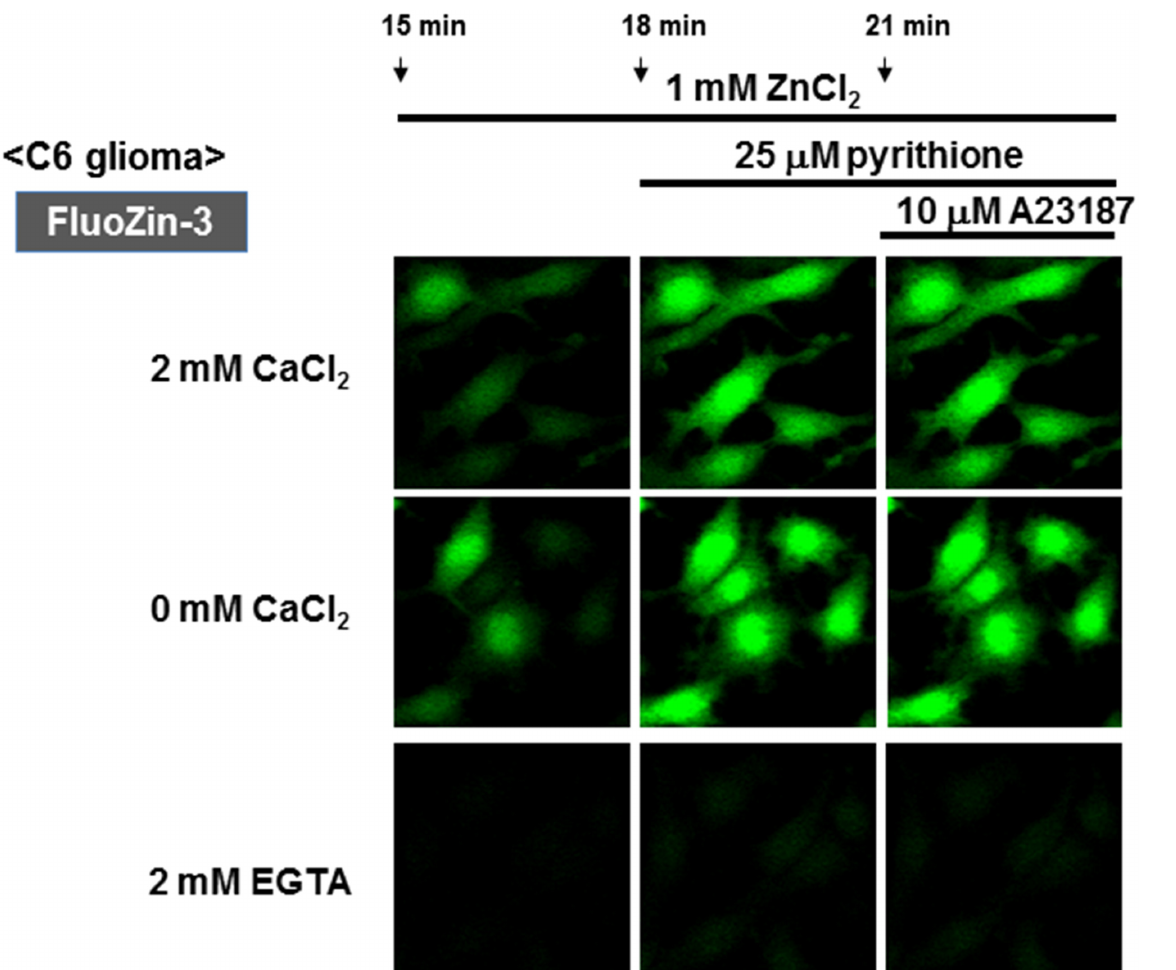
Fig 9. Micrographic pictures of FluoZin-3 fluorescence in C6 glioma cells exposed to CaCl 2 and ZnCl 2 in the presence of A23187 and pyrithione. Typical pictures are shown here.